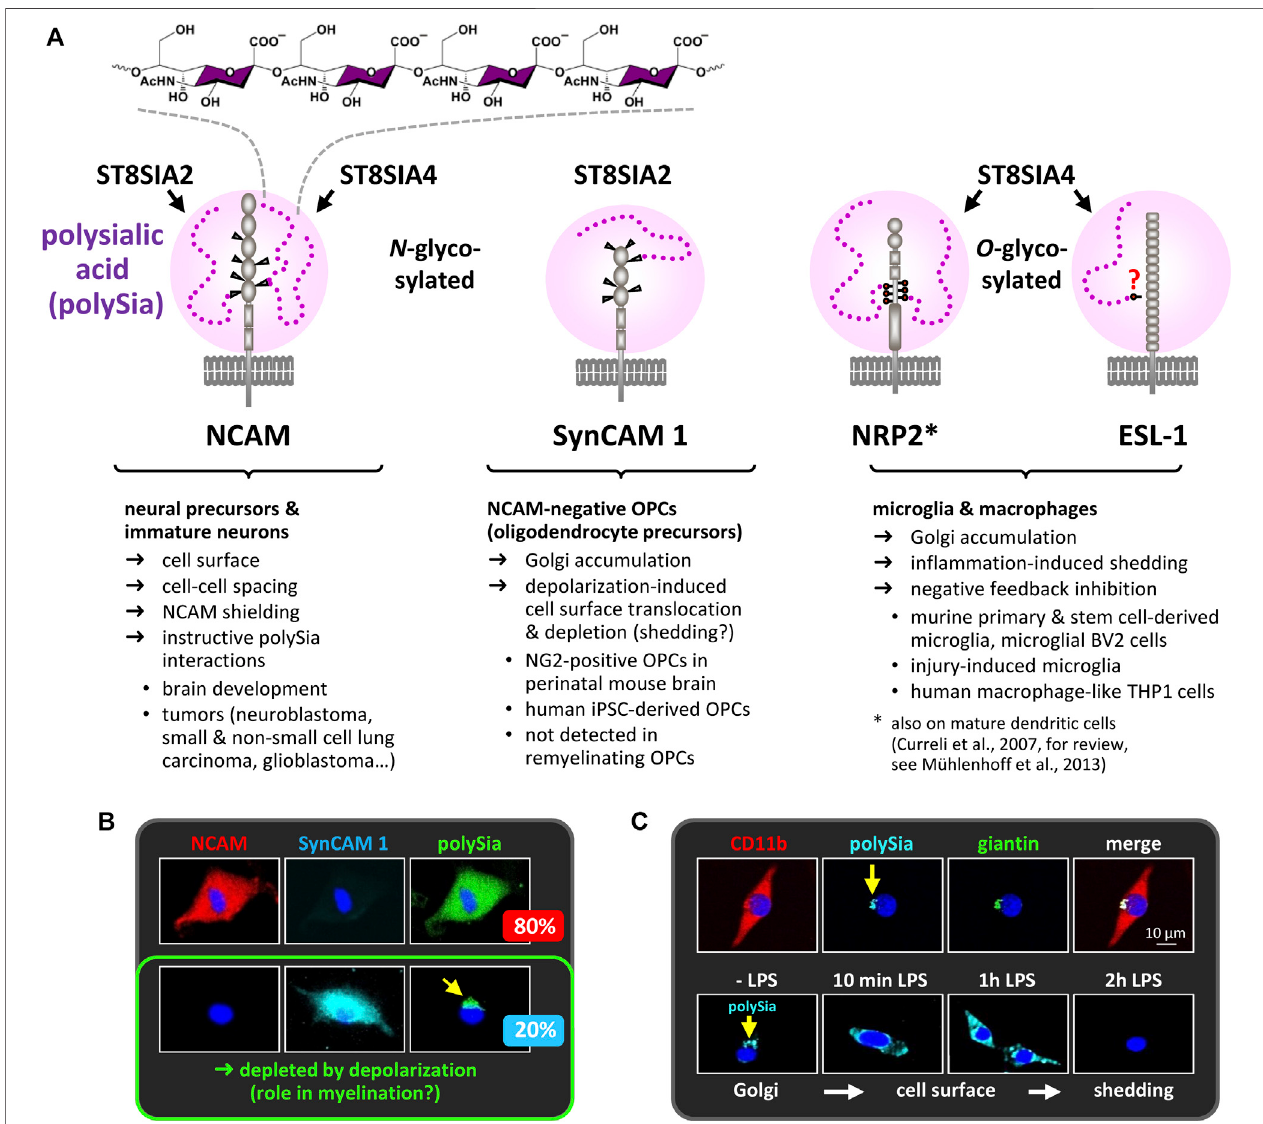
FIGURE 1 | PolySia carriers in the nervous system. (A) PolySia structure and schematic representation of polysialylated NCAM, synaptic cell adhesion molecule 1 (SynCAM 1), neuropilin-2 (NRP2) and E-selectin ligand 1 (ESL-1). Involved polySTs, glycosylation sites, type of the core glycan ( N - or O -glycosylation) and selected characteristics are indicated. (B) In cultured OPCs, polySia-SynCAM 1 is detected in NCAM-negative OPCs comprising a subpopulation of about 20% of all polySia- positive OPCs. In these cells, polySia-SynCAM 1 accumulates in the Golgi-compartment, but is depleted in response to depolarization (Werneburg et al., 2015a). So far, the possible functions of polySia-SynCAM 1 in OPC differentiation and myelination remain elusive. Notably, polySia-SynCAM 1 was not detected during OPC expansion and remyelination in the cuprizone model (Werneburg et al., 2017; see section “ PolySia in myelin maintenance and repair ” ). (C) In cultured microglia (stained with the microglia/macrophage marker CD11b), polySia is also con fi ned to the Golgi compartment, identi fi ed by the marker giantin, but rapidly depleted in response to in fl ammatory activation with bacterial lipopolysaccharide (LPS). See also Figure 2D and section “ PolySia in microglia and macrophage activation ” . Information on polysialylation of SynCAM 1, NRP2 and ESL-1 is based on Curreli et al., 2007, Galuska et al., 2010, Rollenhagen et al., 2012, 2013, Werneburg et al., 2015a, 2015b, 2016, 2017, and Thiesler et al., 2021. Images in Panels B and C are reproduced from Werneburg et al., 2015a and 2016 with permission from Wiley.